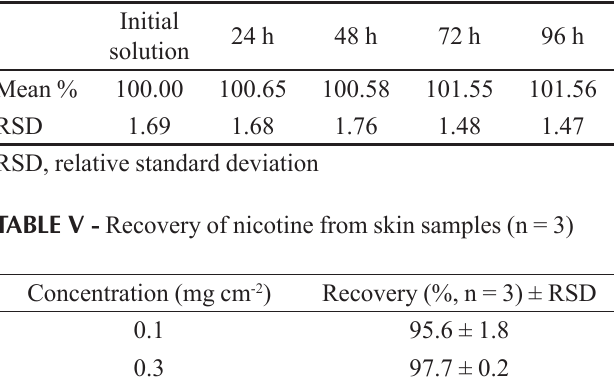
TABLE IV - Stability of nicotine in receptor phase (n = 3) Initial